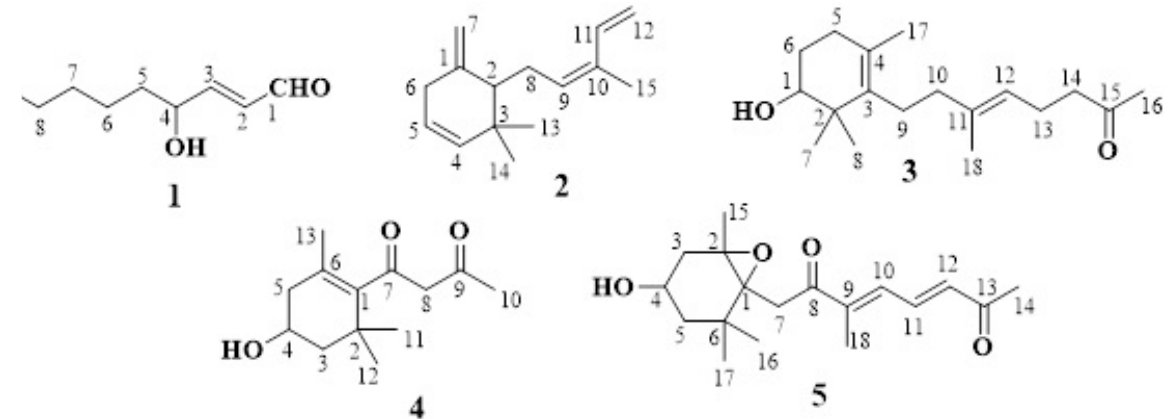
FIGURE 1 – Identified secondary metabolites from seaweed Chara baltica .